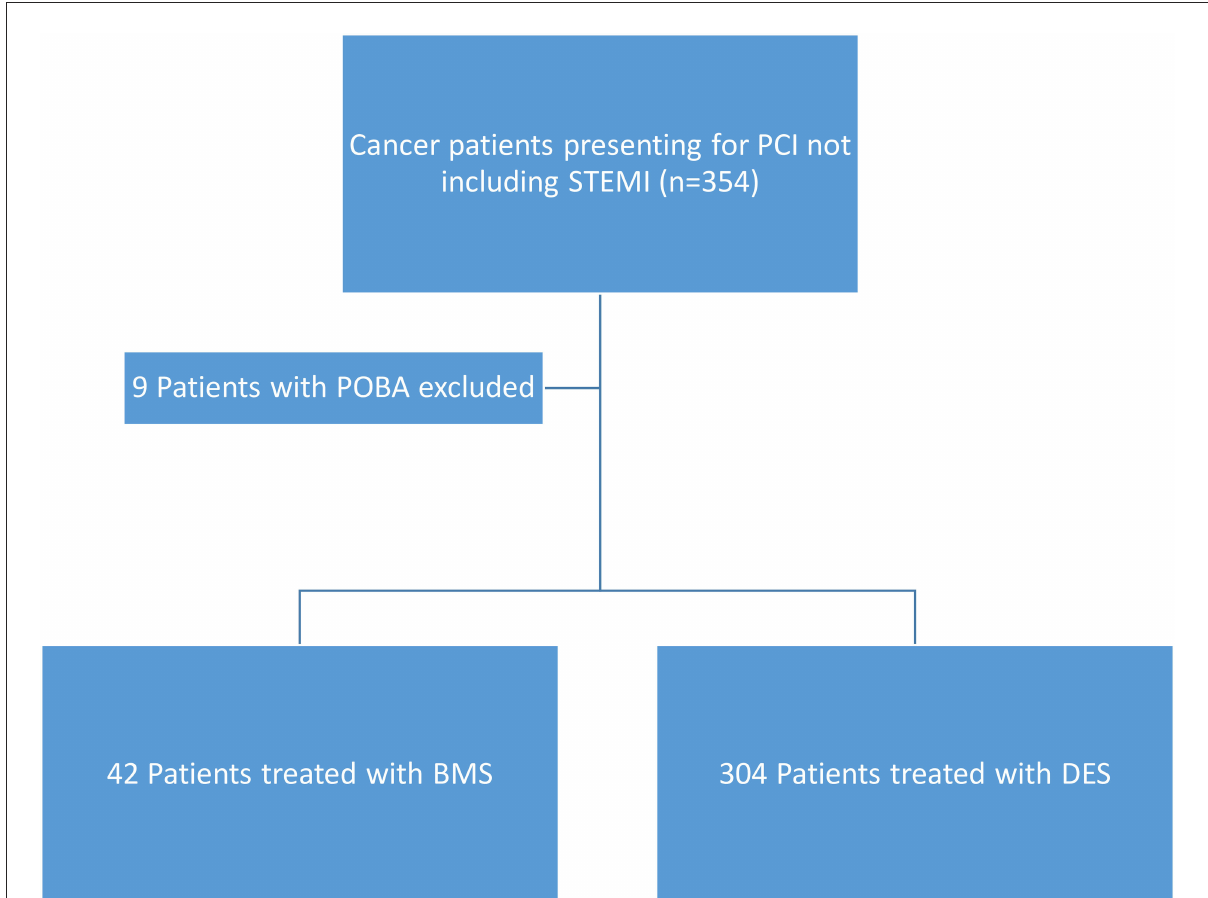
FIGURE3 Patient flow chart showing inclusion criteria for the patients. STEMI, ST-elevation myocardial infarction; POBA, plain old balloon angioplasty; BMS, bare metal stents; DES, drug-eluting stents.